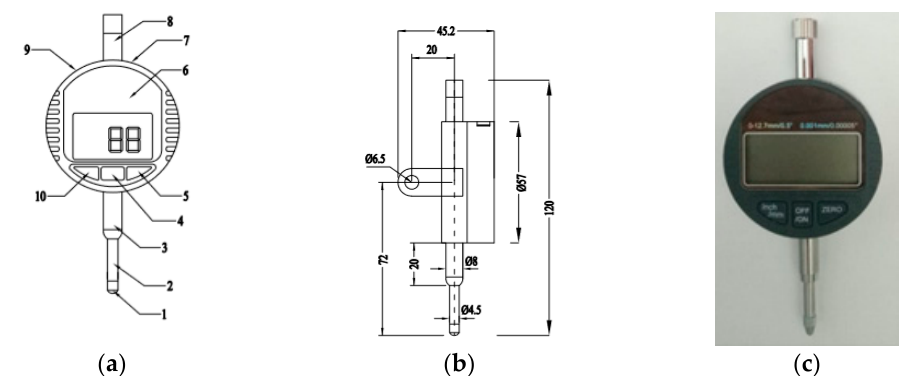
Figure 1. Device for shrinkage test.